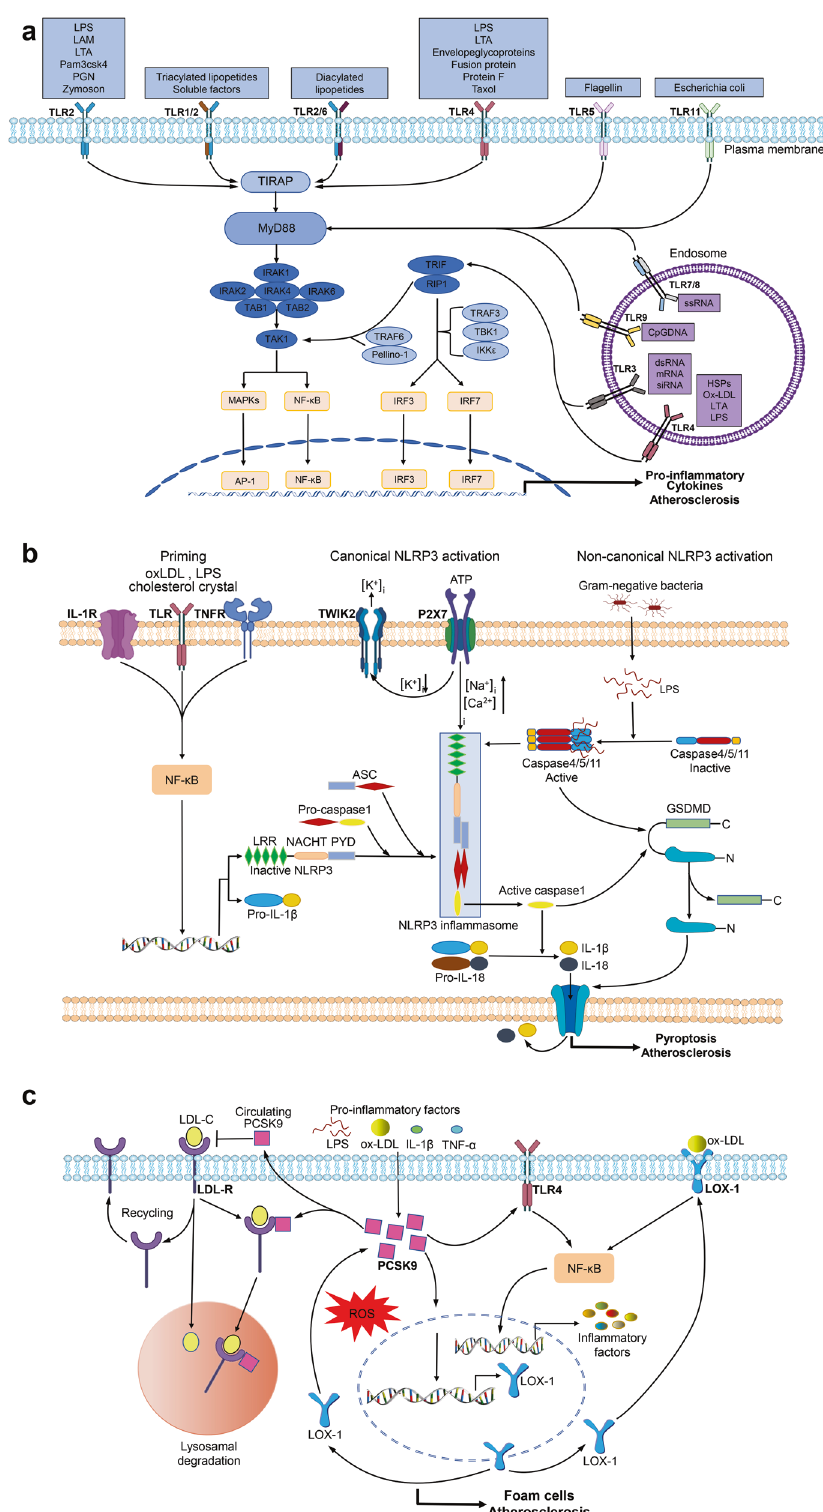
disease. 96 Besides the production of antibodies, B cells also